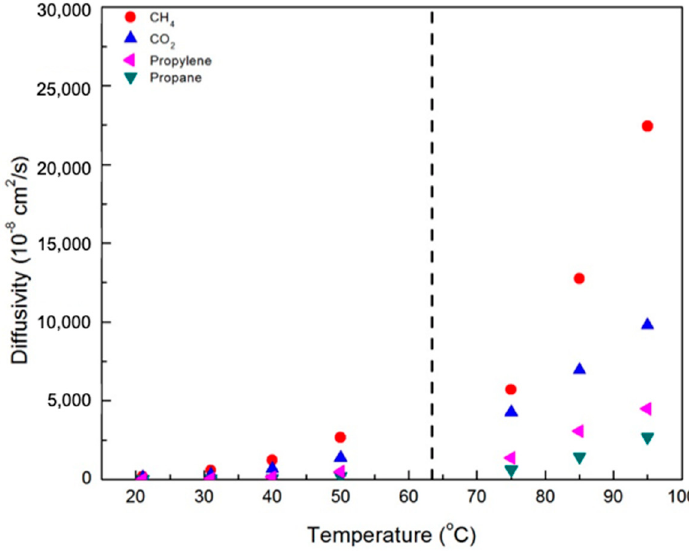
Figure 8. Diffusivity of various gases in the CNBPh75_5.0 membrane (5.0% crosslinker) in the nematic and isotropic phases. The dashed line indicates the nematic–isotropic transition temperature. An expanded view of the nematic region is given in the supporting information.